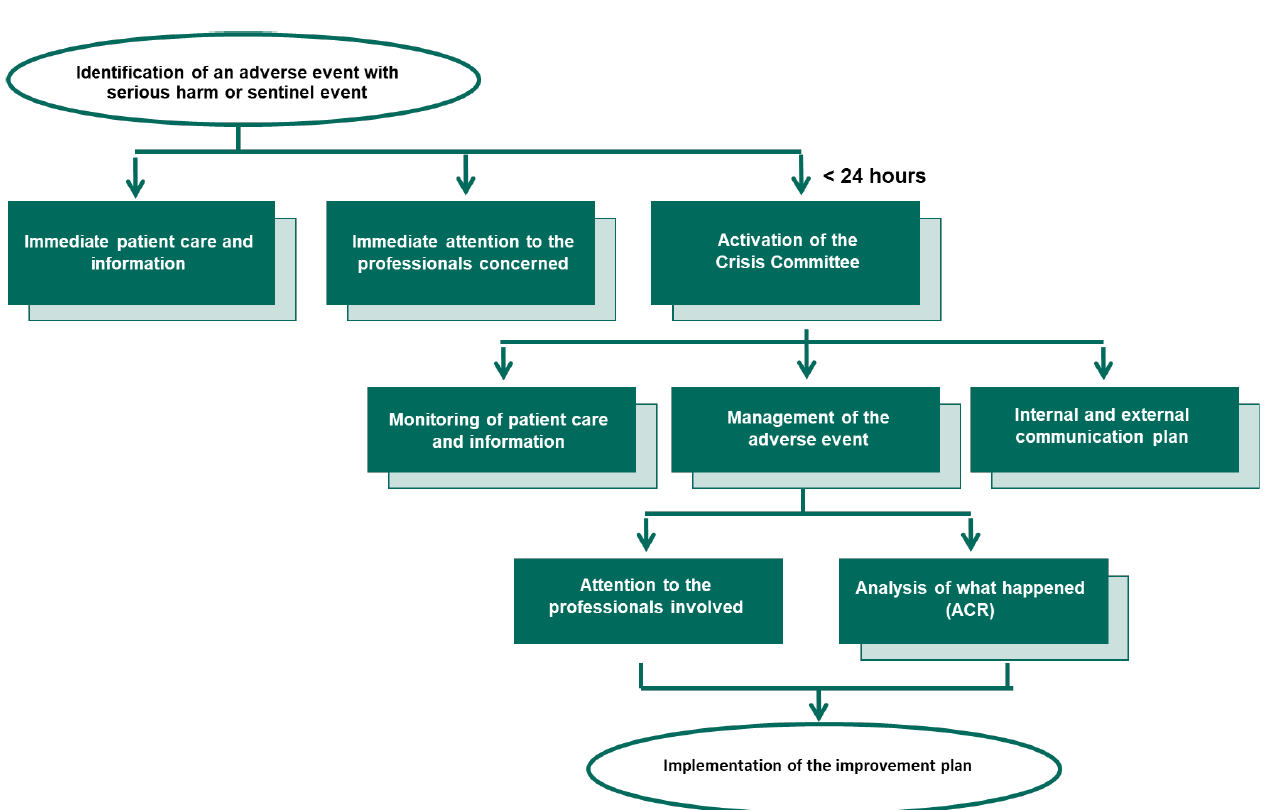
Figure 1. Flow chart of the operational Procedure for Serious Adverse Events.